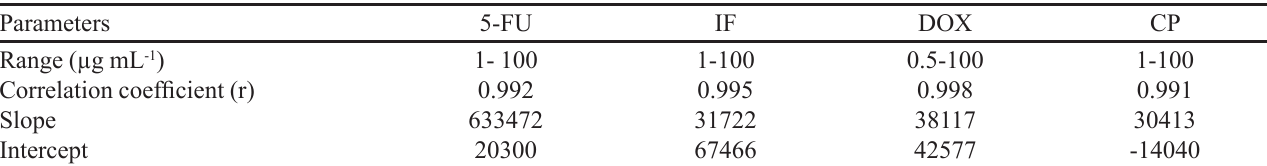
TABLE II - Analytical curve parameters for simultaneous determination of fluorouracil (5-FU), ifosfamide (IF), doxorubicin (DOX) and cyclophosphamide (CP) by HPLC-DAD-UV Parameters 5-FU IF DOX CP